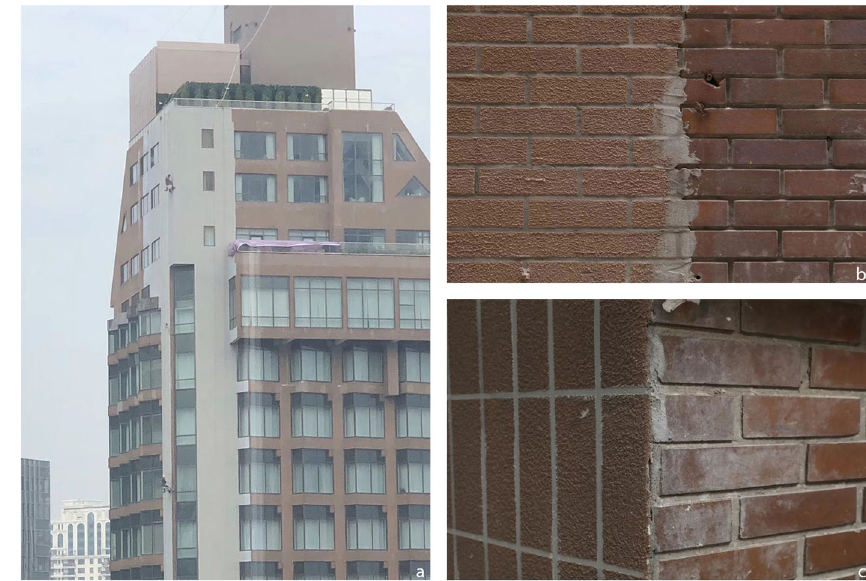
Fig. 14 Exterior facade coated with lacquer (construction site and details) (Sources: a Fan 2018; b , c Wu